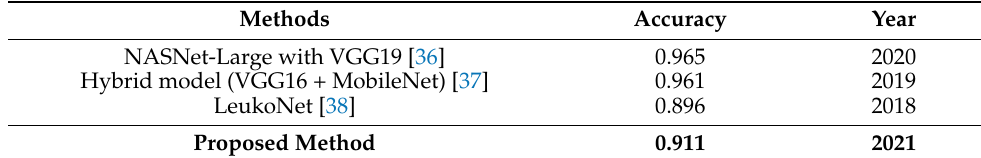
Table 7. Performance comparisons between our proposed method and other approaches.